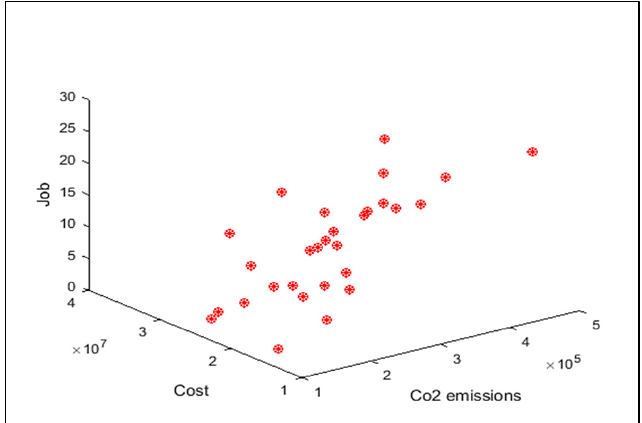
Figure 25. Pareto front of the first test problem from MOPSO.